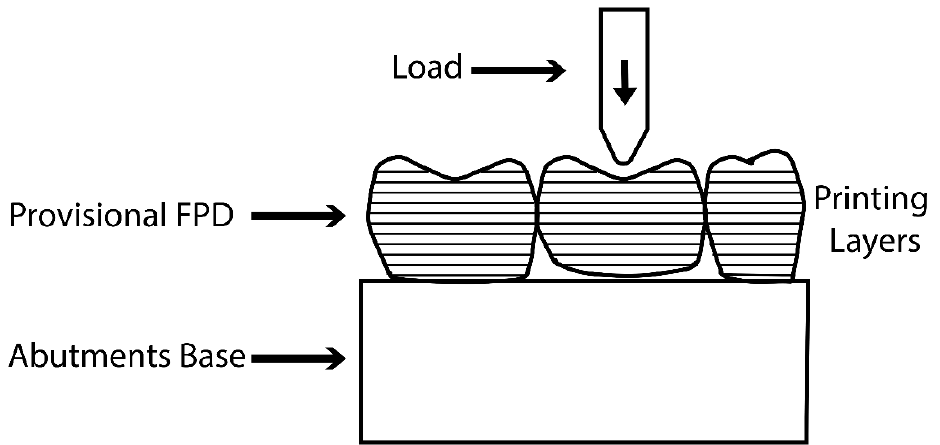
Figure 6. Prepared specimen with the provisional prosthesis loaded on the Instron machine (0-degree group).